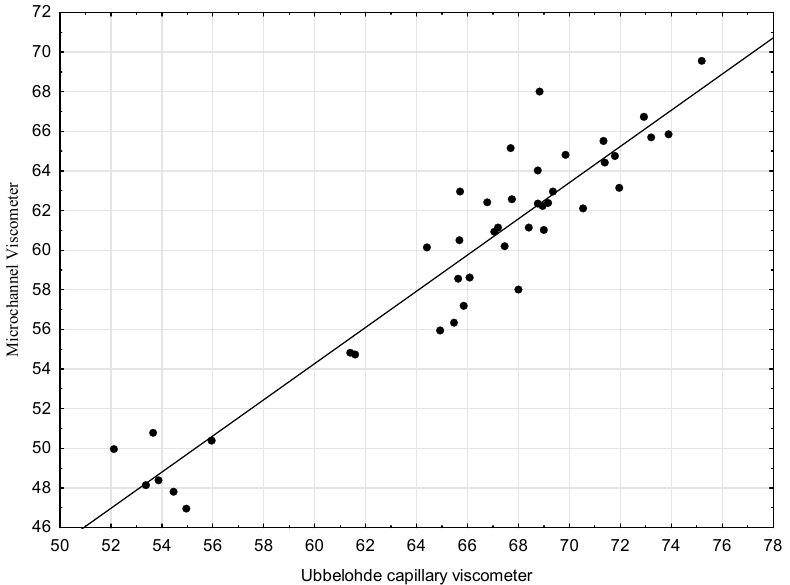
Figure 2. Scatter plots with regression lines for the kinematic viscosity—Capillary viscometer and Microchannel viscometer.